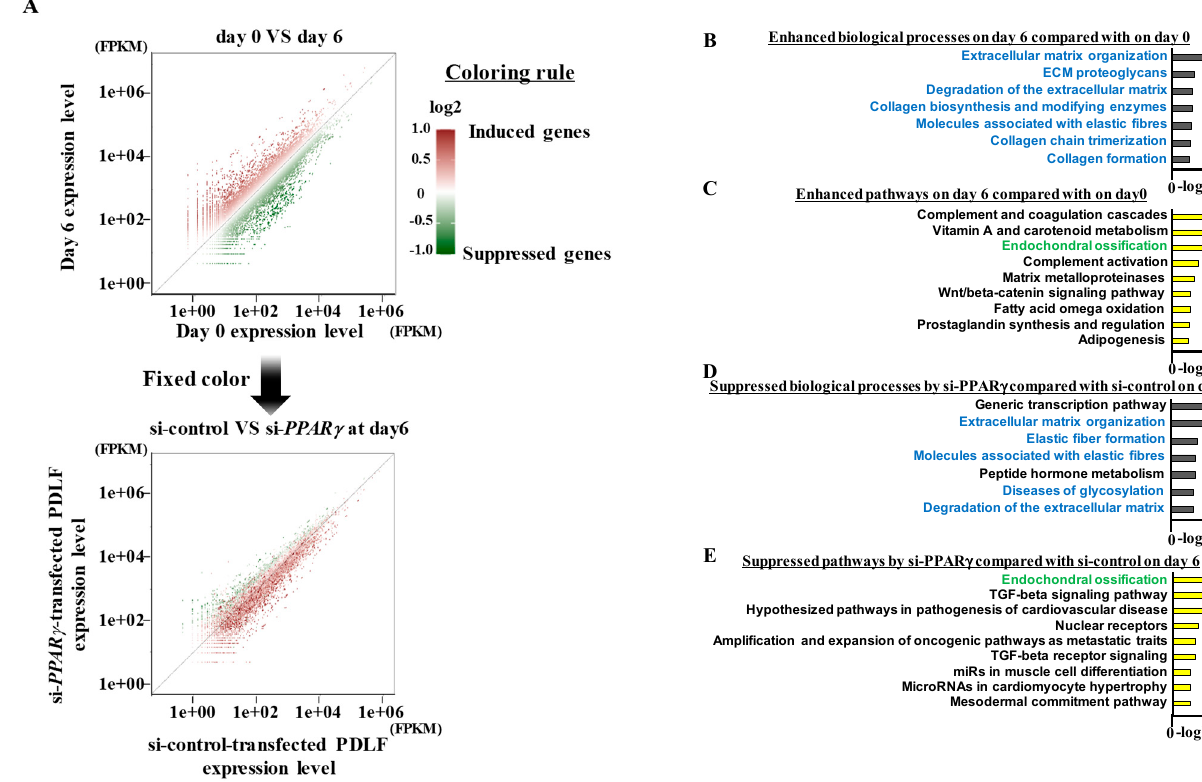
Figure 5. PPAR γ suppression comprehensively reduces the expression of ECM- and ossification-related genes in PDLF. ( A ) PDLF-1 were transfected with si-control or si- PPAR γ and then cultured for 6 days in induction medium. Total RNAs were collected before and after the culture and whole genomic transcriptional changes were assessed by RNA-seq. The upper scatterplot shows a comparison before (day 0: x-axis) and after (day 6: y-axis) the long-term culture of si-control-transfected PDLF. The color of each gene spot is linked with a gradient in proportion to its expression ratio (day 6/day 0), with a darker red color for spots having a higher ratio and a darker green color for those with a lower ratio. The middle color is set as white. The lower scatterplot shows a comparison between si-control-transfected PDLF (x-axis) and si- PPAR γ -transfected PDLF (y-axis). The color of each gene spot was taken over from the upper scatterplot. ( B – E ) Pathway analyses of biological processes ( B , D ) and wikipathways ( C , E ). Enhanced terms on day 6 from those on day 0 (si-control-transfected cells) ( B , C ) and suppressed terms by si- PPAR γ from si-control on day 6 ( D , E ).